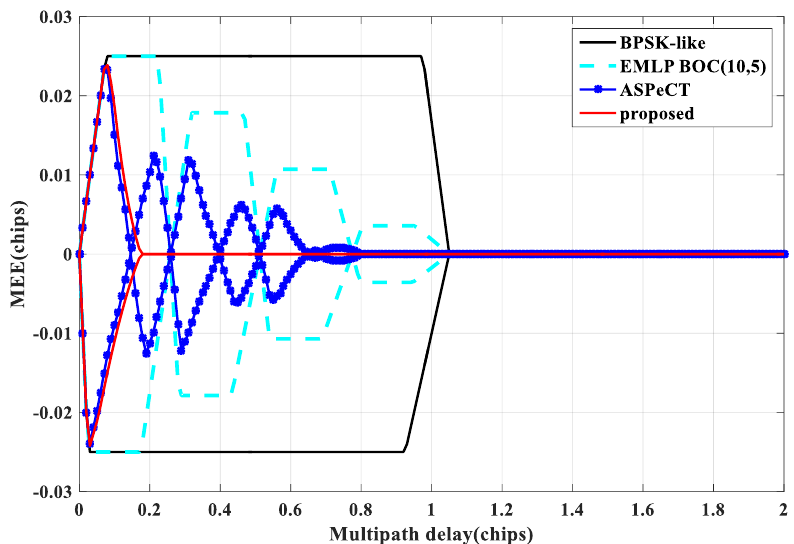
Sensors 2020 , 20 , x FOR PEER REVIEW Figure 21. Multipath error envelope of BOC(1,1). Figure 21. Multipath error envelope of BOC(1, 1).